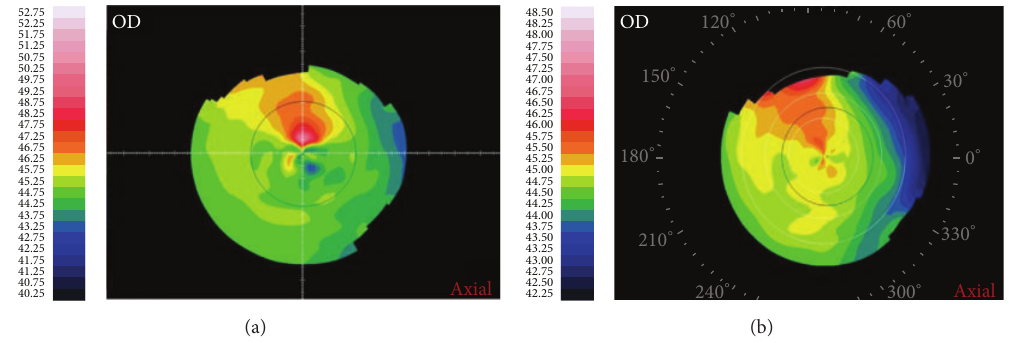
Figure 1: Corneal topography image of one patient receiving treatment (axial power